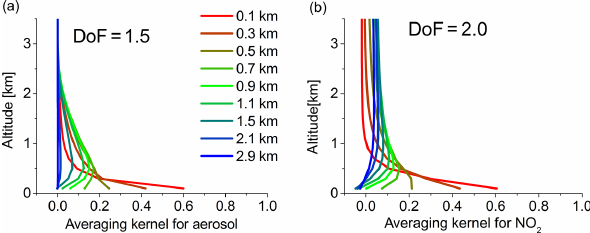
Figure 5. A totally averaged averaging kernel of aerosol (a) and NO 2 (b) retrievals for all the MAX-DOAS measurements for clear- sky conditions with low aerosol loading. DoF is the degrees of free- dom related to the averaging